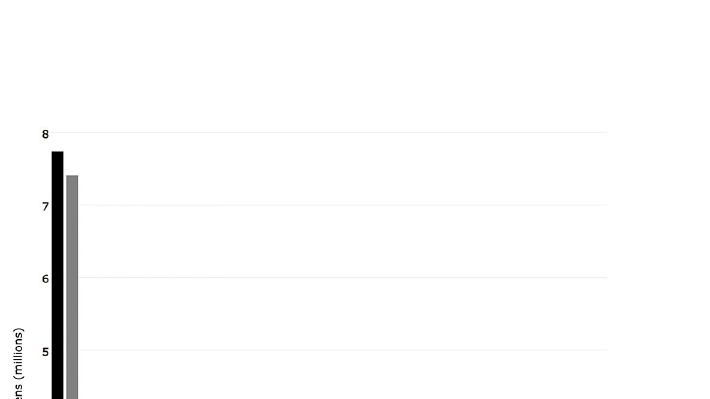
Fig 3. Number of specimen records (lots) returned for the 38 fish collections with recordsets in iDigBio.